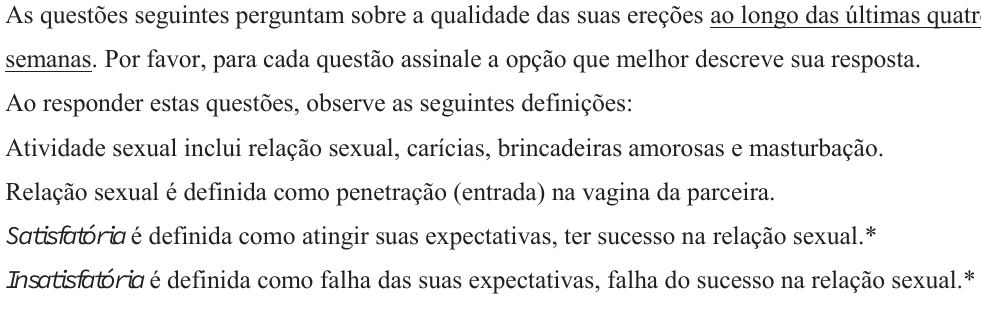
Figure 1 - Final version of the EQF in Portuguese